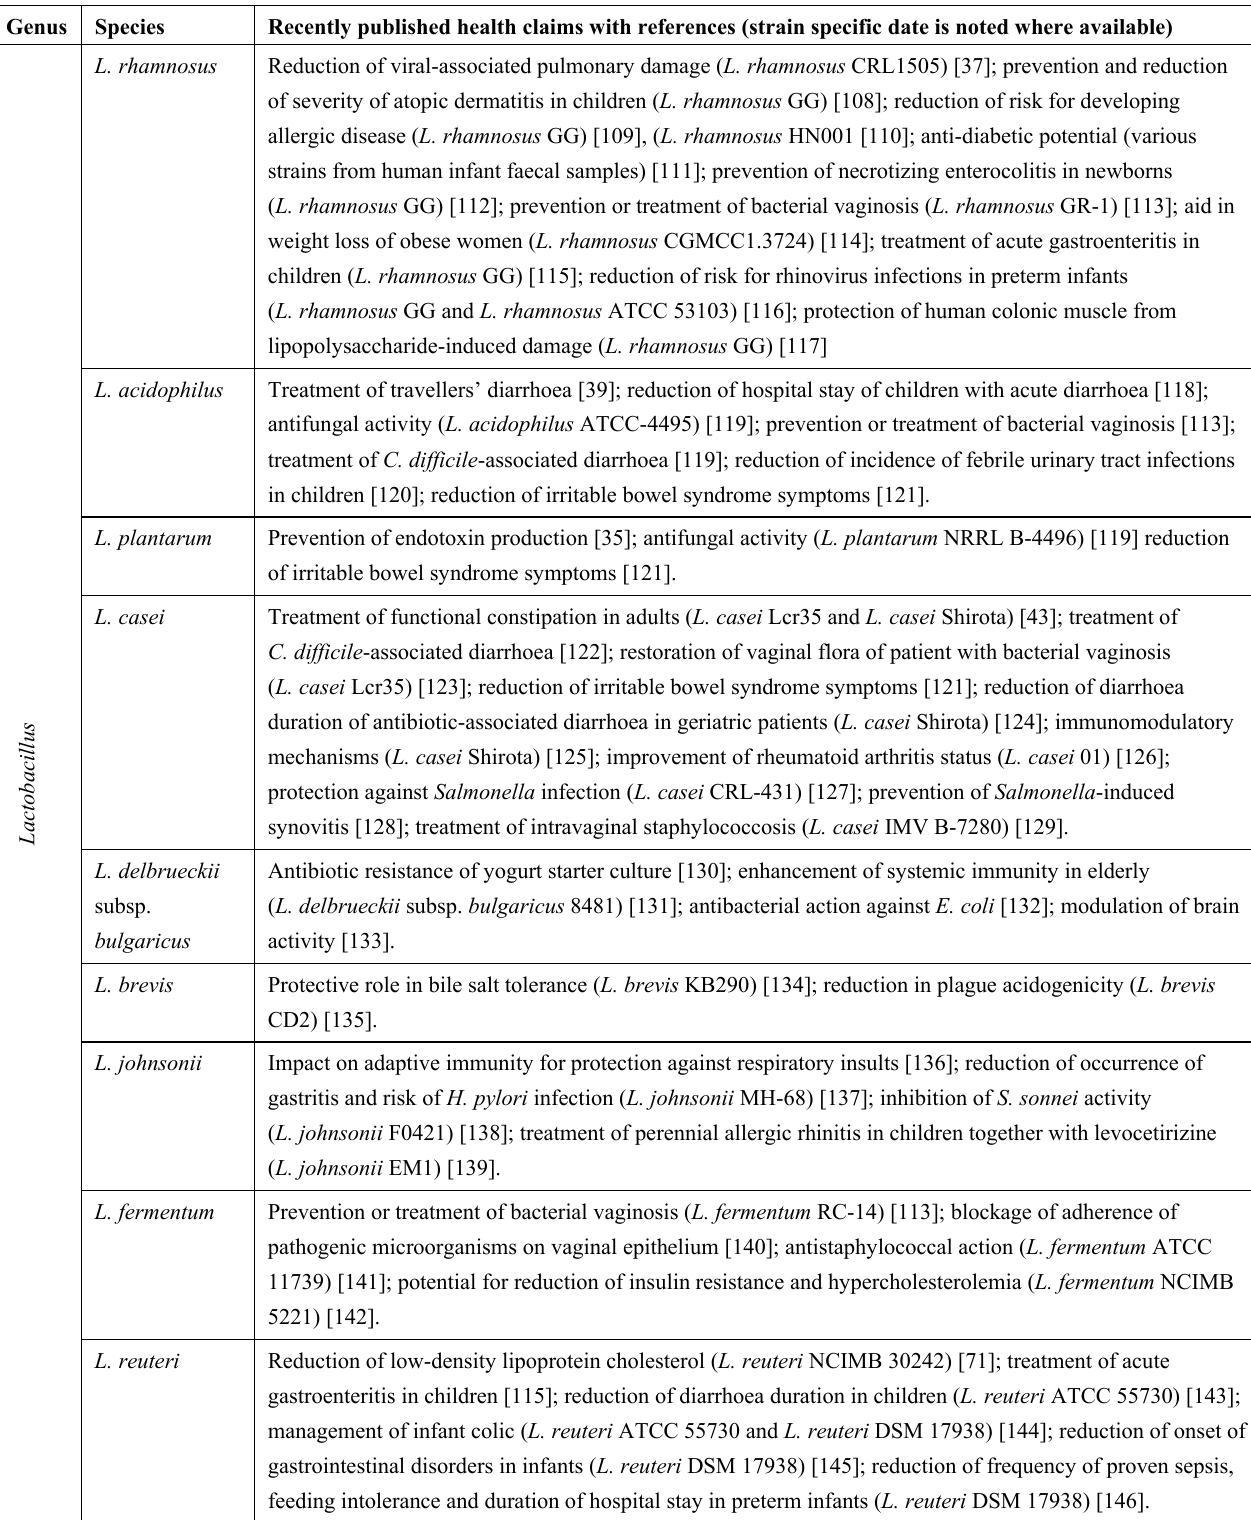
Table 1. Recently published claimed health benefits of probiotic